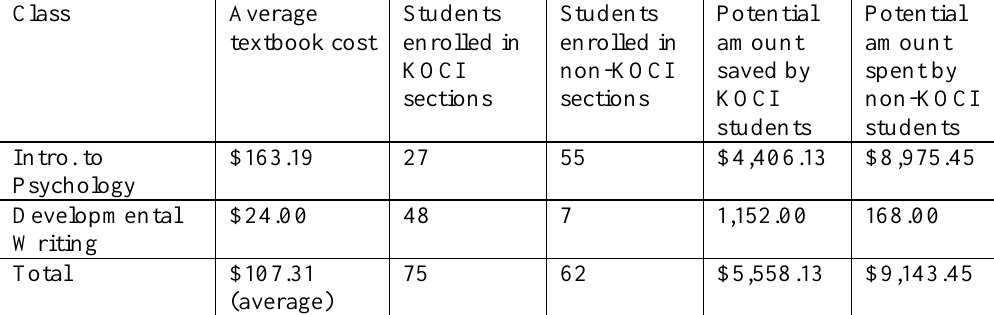
Chadron State College Costs per